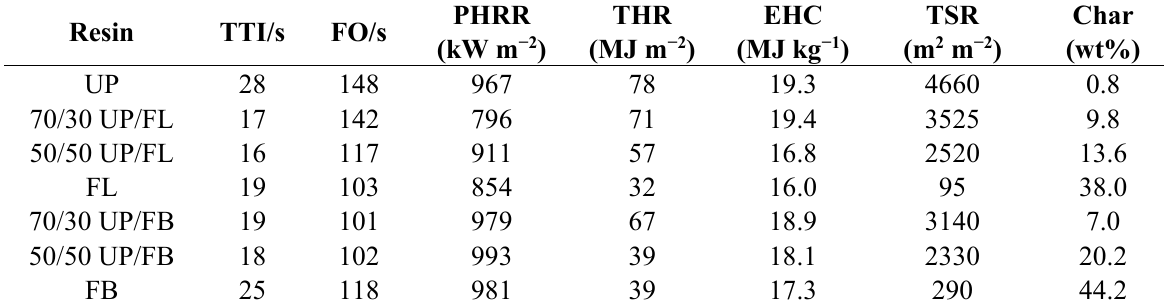
Table 4. Cone calorimetric data for cured resins and resin blends